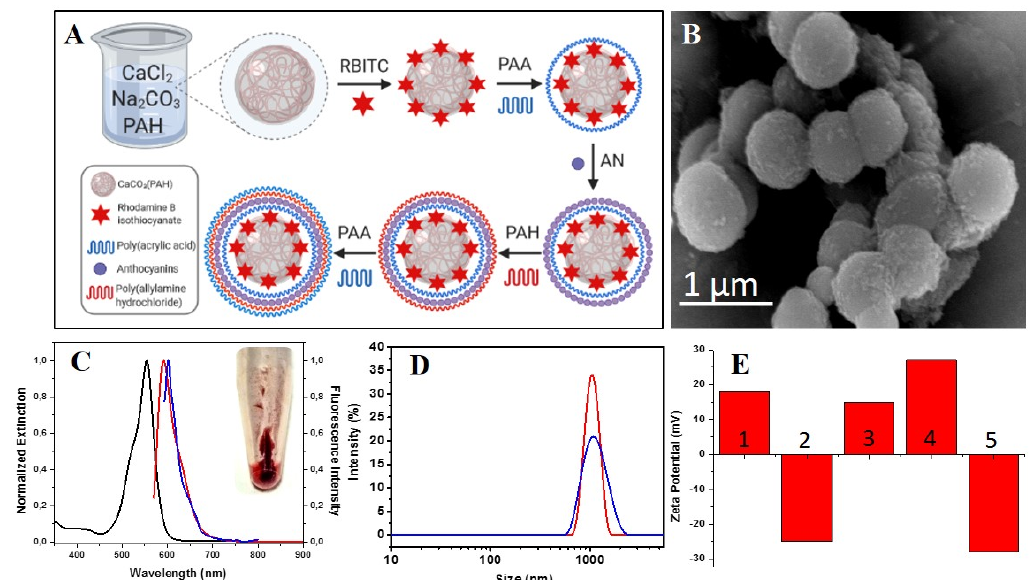
Figure 1. ( A ) Schematic diagram illustrating the fabrication process of CaCO 3 (PAH)@RBITC@AN; ( B ) TEM image of CaCO 3 (PAH)@RBITC@AN microcapsule; ( C ) Spectral overlap between the normalized absorbance (black spectrum) and fluorescence spectra (red spectrum) of free RBITC fluorophore compared to the fluorescence emission of CaCO 3 (PAH)@RBITC@AN (blue spectrum); ( D ) DLS measurements of CaCO 3 (PAH) template (red spectra) and as-obtained CaCO 3 (PAH)@AN(RBITC) microcapsules (blue spectra); ( E ) Zeta potential data recorded after each step: (1) CaCO 3 (PAH)@RBITC, (2) CaCO 3 (PAH)@RBITC-PAA, (3) CaCO 3 (PAH)@RBITC-PAA/AN, (4) CaCO 3 (PAH@RBITC- PAA/AN/PAH, (5) CaCO 3 (PAH@RBITC-PAA/AN/PAH/PAA.